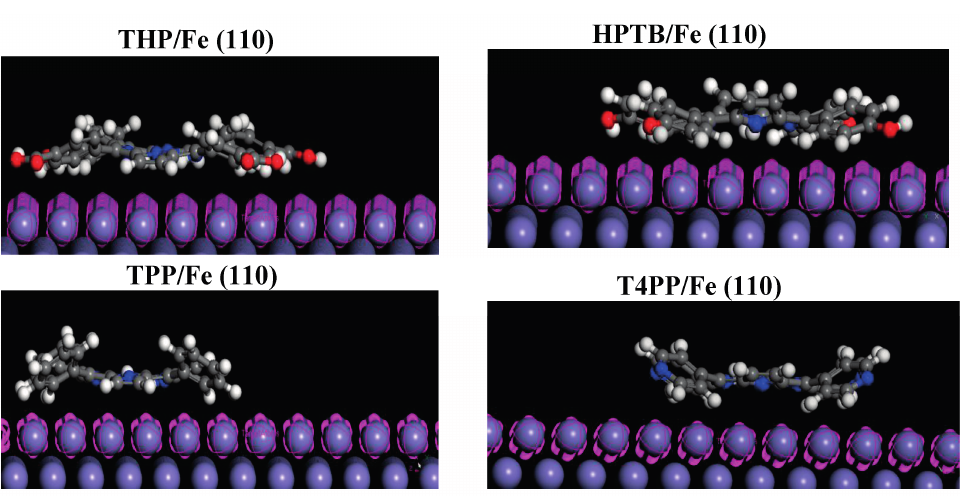
Figure 11. The most stable adsorption configuration of THP, HPTB, TPP and T4PP on Fe (110) surface using Monte Carlo